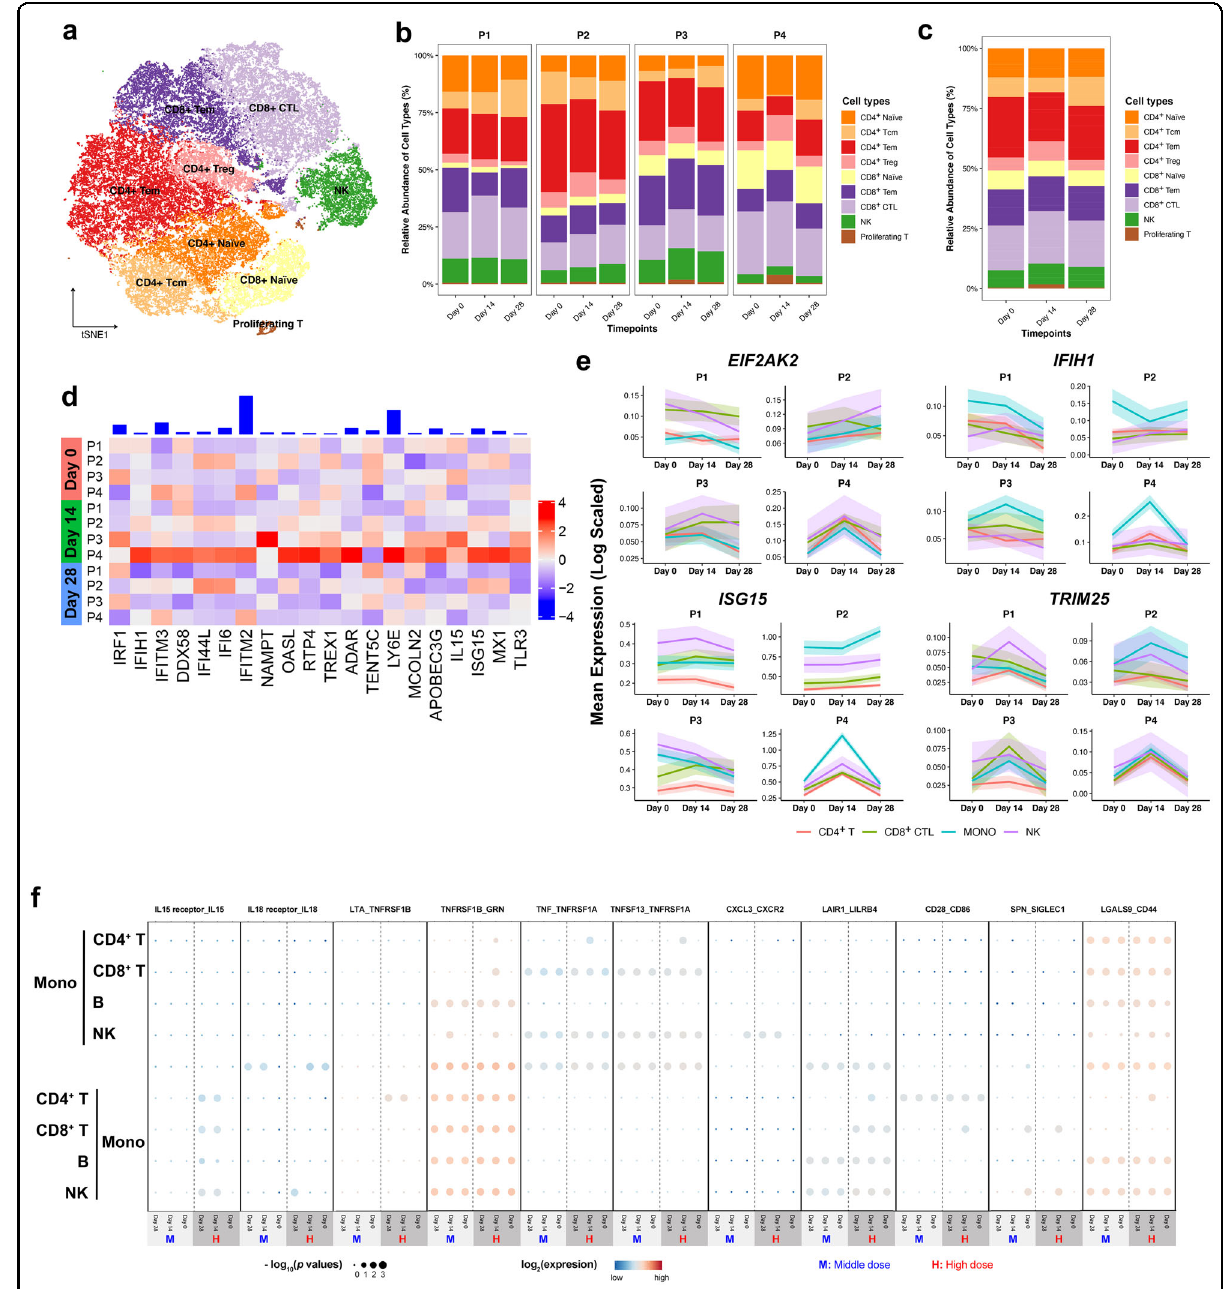
Fig. 4 Cellular immune response peaked at day 14 post-vaccination. a t -SNE analysis of NK and T cell subtypes from all participants and timepoints. b Proportions of the NK and T cell subtypes in the total NK and T cells from participants at different timepoints by scRNA-seq. c Proportions of NK and T cell subtypes of each sample in the total NK and T cells. d Heatmap of z-scored mean expression of IFN-response signature (de fi ned as the normalized mean expression of genes in the activation signature in Supplementary Table S3) across T cells from each participant and timepoint. Top, bar plot of total expression of each gene, across all patients. e Mean expression of four common ISGs ( EIF2AK2 , IFIH1 , ISG15 , and TRIM25 ) in CD4 + T, CD8 + T, monocytes and NK cells, which are indicated by timepoints and individuals. Shaded area denotes 95% CI of the mean value. f Dot plot of the interactions (predicted by ligand/receptor interaction database cellPhoneDB) between monocytes and other immune cell types in the middle- and high-dose group. P values are indicated by the circle sizes, as shown in the scale on the bottom. The means of the average expression level of interacting molecule 1 in cluster 1 and interacting molecule 2 in cluster 2 are indicated by the